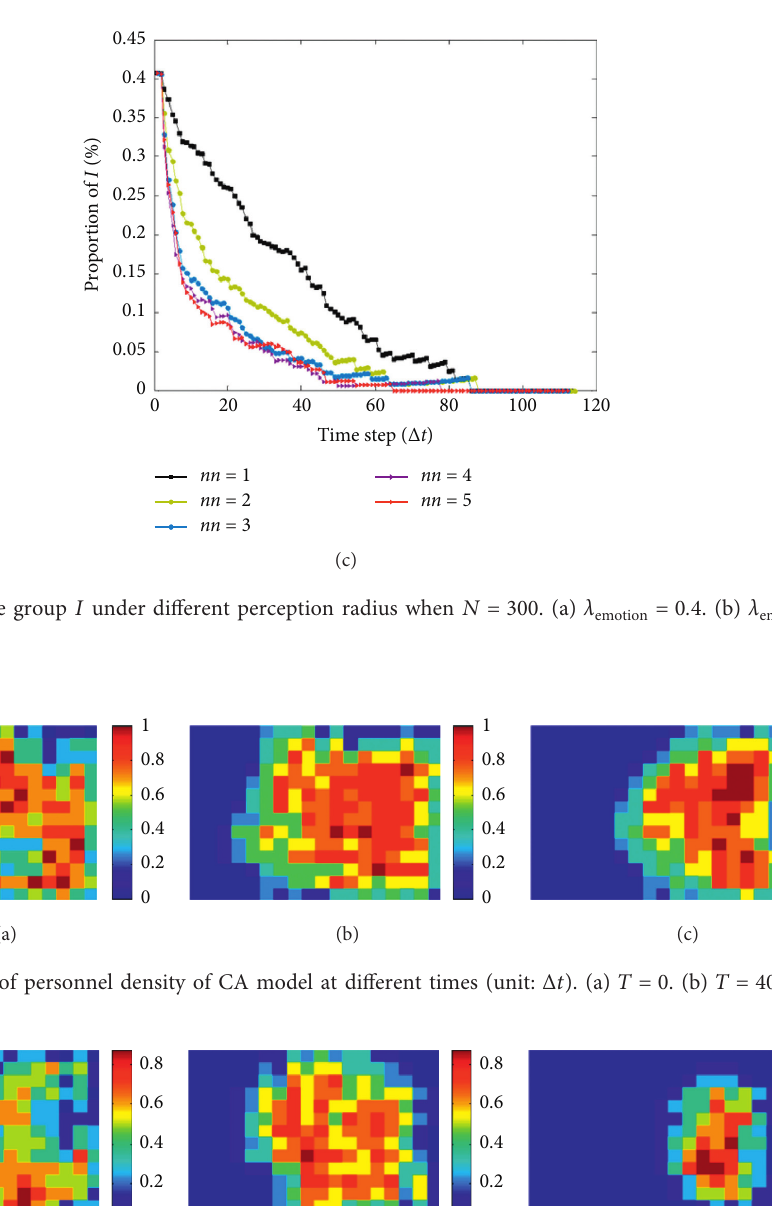
Figure 21: Diagram of personnel density of the improved model at different times (unit: Δ t ). (a) T � 0. (b) T � 40. (c) T �